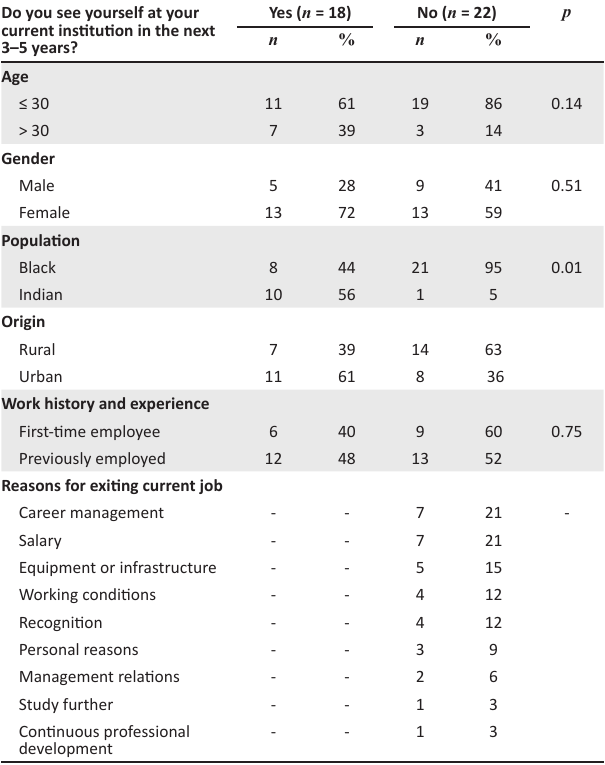
TABLE 3: Profile and intentions of public sector optometrists over the next 3–5 years. Do you see yourself at your current institution in the